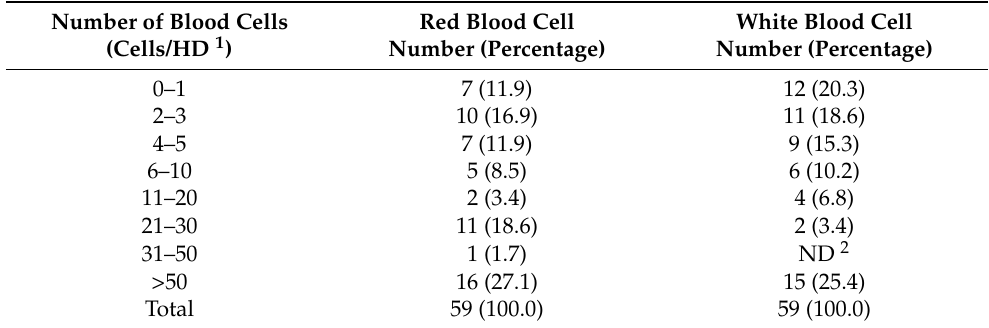
Table 1. Number (Percentage) of the fecal smear samples prepared using 10% isotonic formalin in which RBC and WBC were detected at different numbers (Cells/HD) (n = 59).